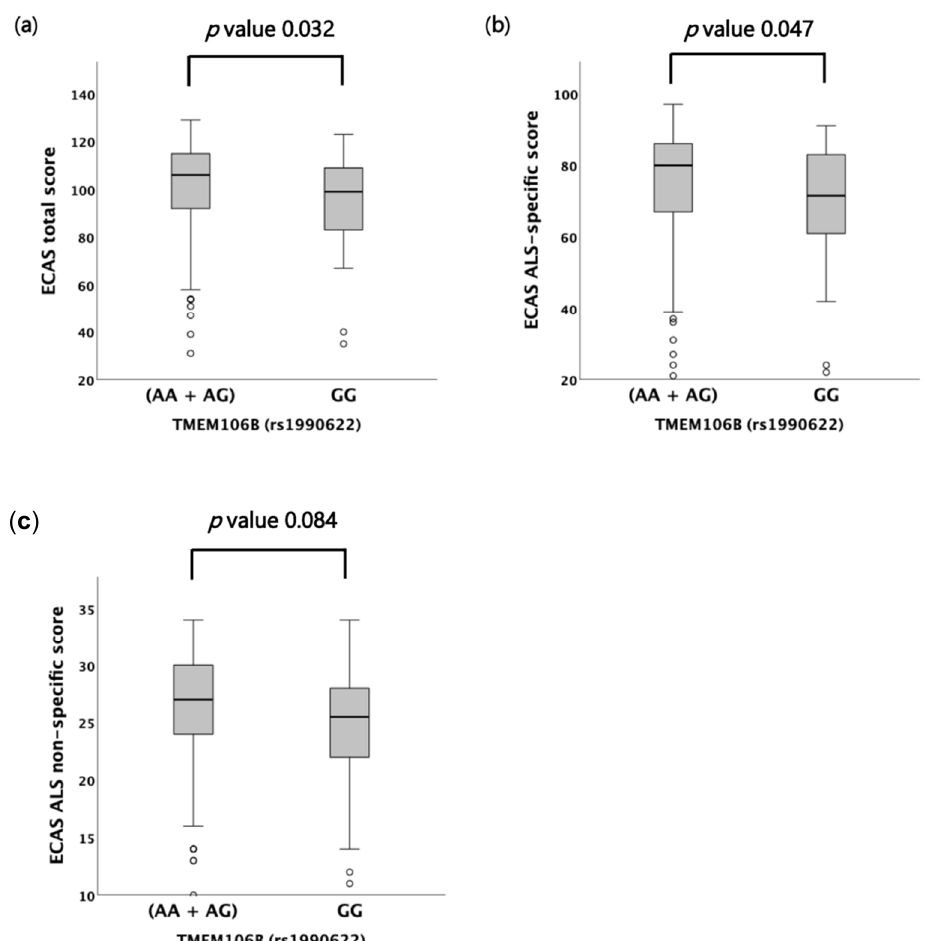
Figure 2. Distribution of ECAS total, ALS-specific and ALS-non-specific scores amongst TMEM106B rs1990622 genotypes according to the Kruskal–Wallis one-way analysis of variance for independent samples under the recessive model. ( a ) ECAS total score. ( b ) ECAS ALS-specific score. ( c ) ECAS ALS-non-specific score. For each group, the bold line shows the median, the gray box represents the interquartile range (IQR) and whiskers show the 5° and 95° percentiles. Empty circles represent outliers.